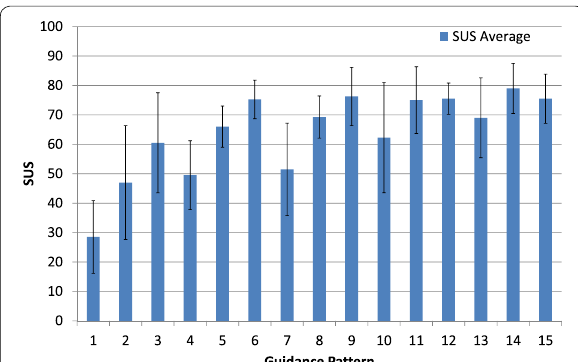
Fig. 7 SUS score for each guidance pattern. The blue lines are the average of SUS scores for each guidance patterns. The black lines indicate the standard